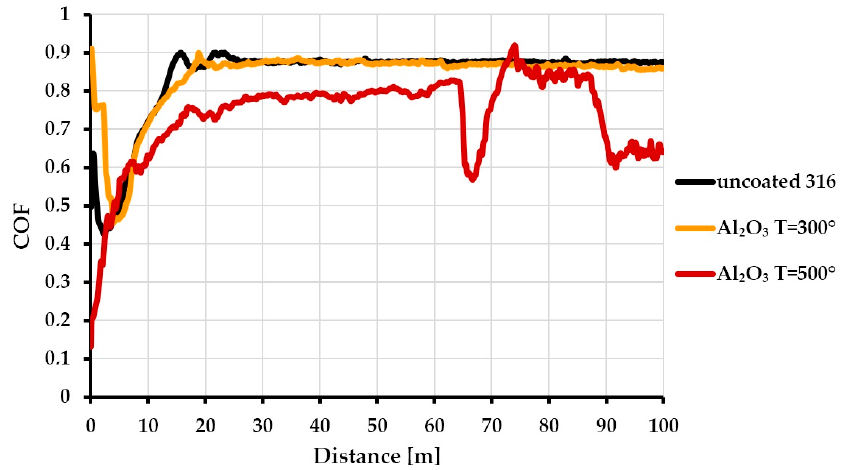
Figure 6. The ball-on-disc tests of uncoated 316 steel and Al 2 O 3 coatings heat treated at 300 °C and 500 °C. COF, coefficient of friction.